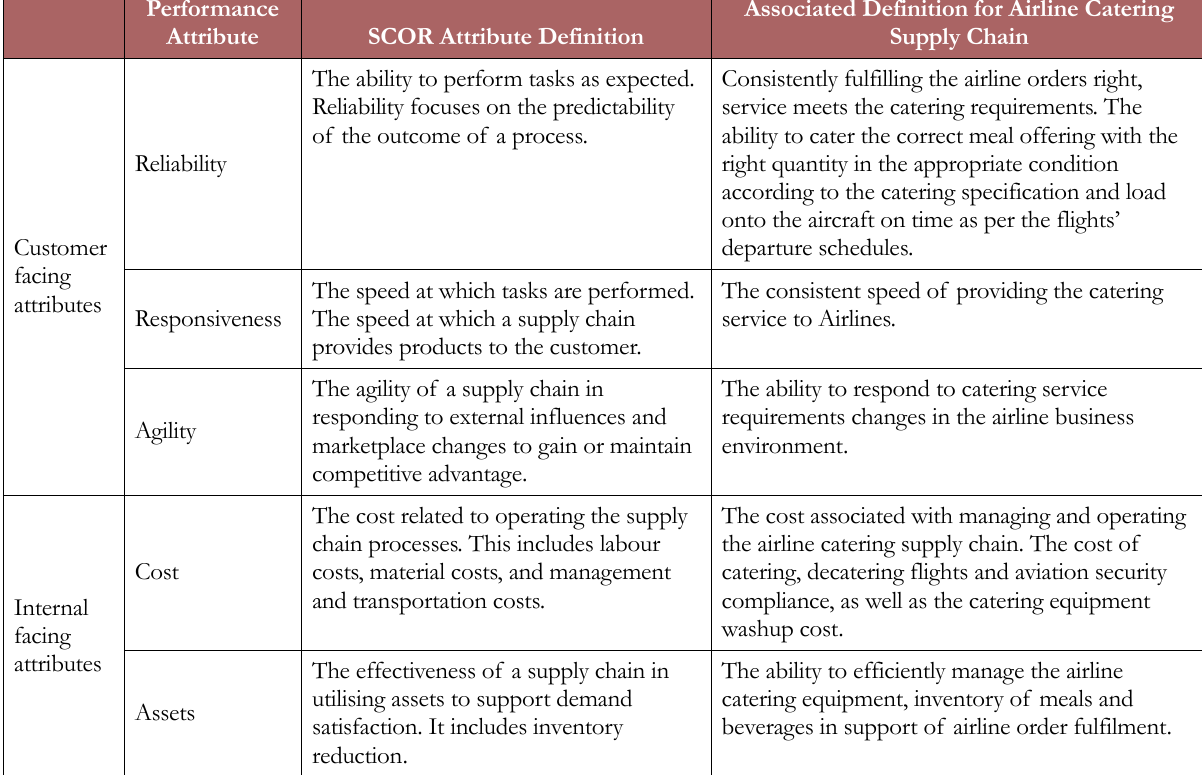
Table 3. Linking SCOR performance attributes with airline catering logistics